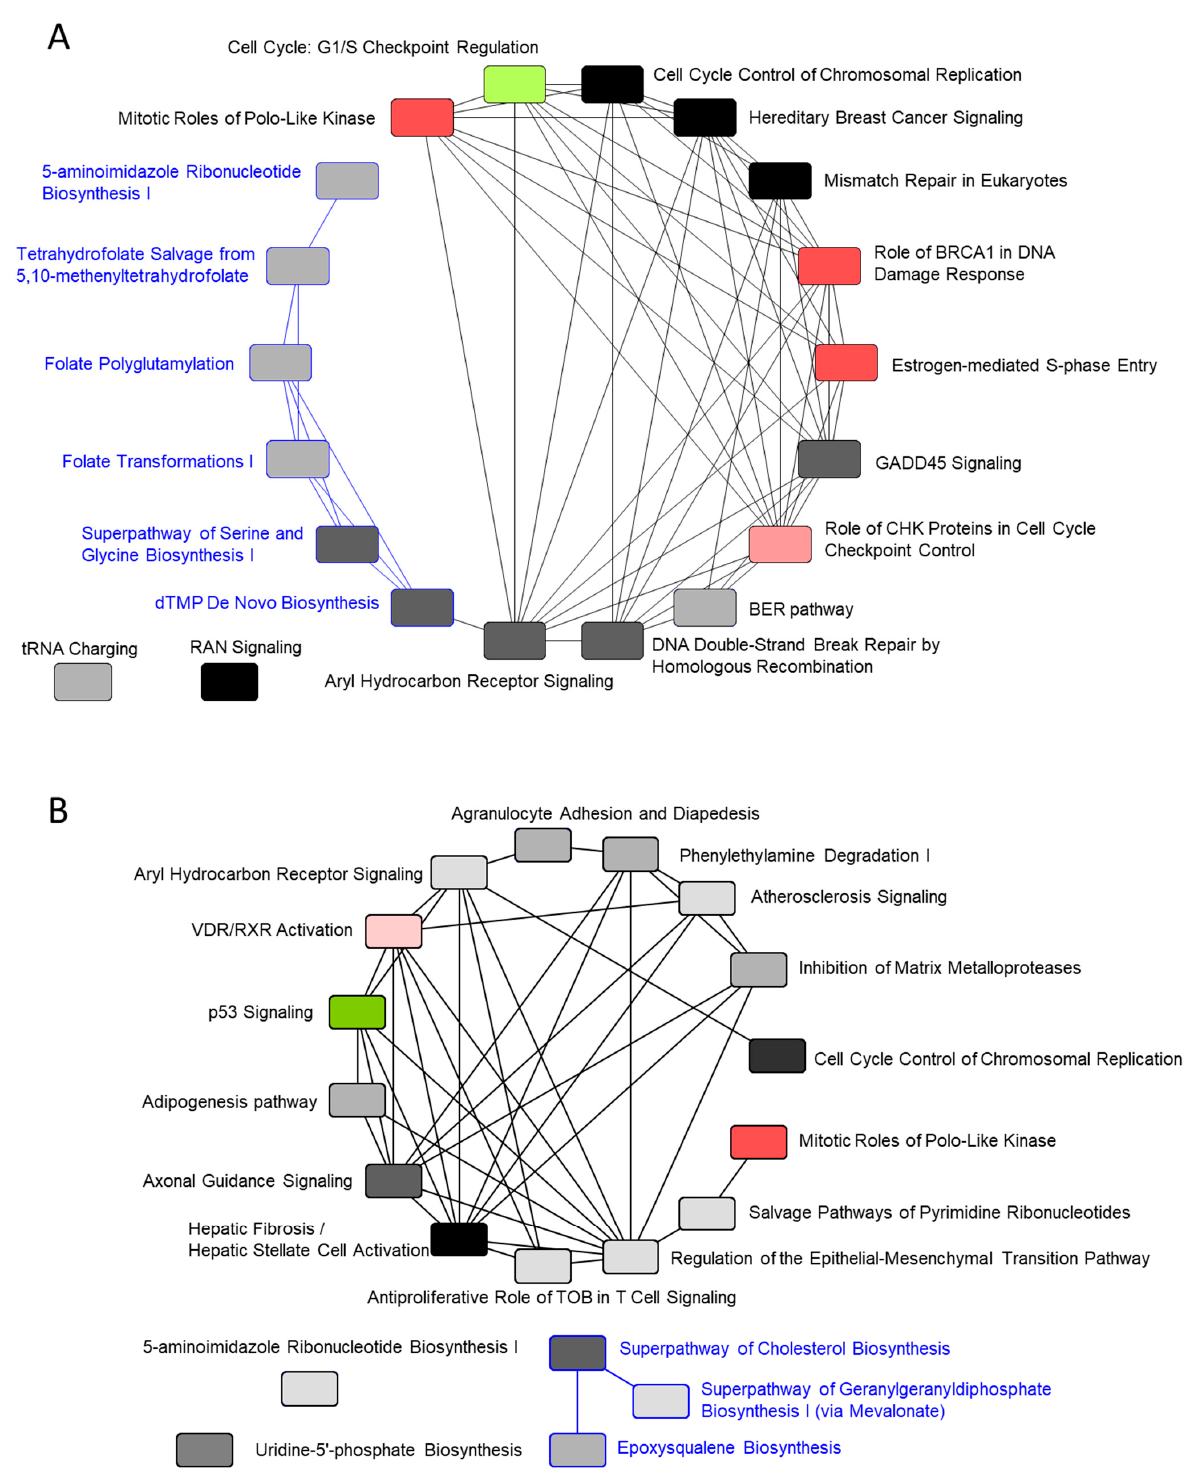
Figure 6. Overlapping of the top-25 canonical pathways. TPA treatment for ( A ) 24 h and ( B ) 8 days. The color of the pathway is red when the z-score is larger than 0, and greenish when it is below 0. When the z-score is 0, the color is distinguished by the brightness of the monotone according to the value of the − log ( p -value). Common genes among the respective pathways are connected by lines. The pathway connected by the blue line in ( A ) is the pathway of folate metabolism. The pathway connected by the blue line in ( B ) is the pathway for the biosynthesis of cholesterol.